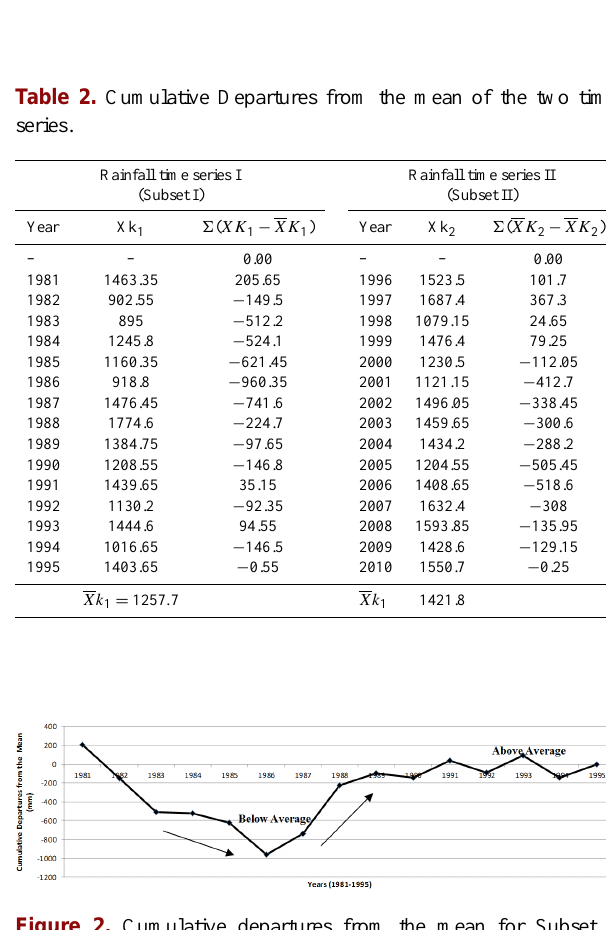
Figure 2. Cumulative departures from the mean for Subset 1 (1981–1995).